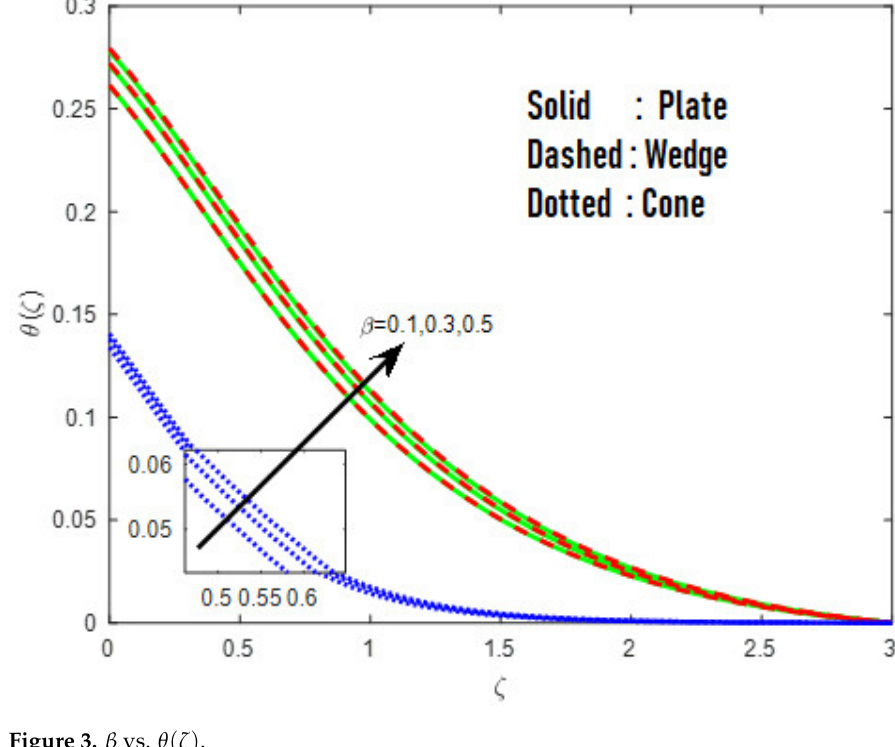
 vs. Figure 3. β vs. θ ( ζ ) . Figure 3. Figure 3.  vs.